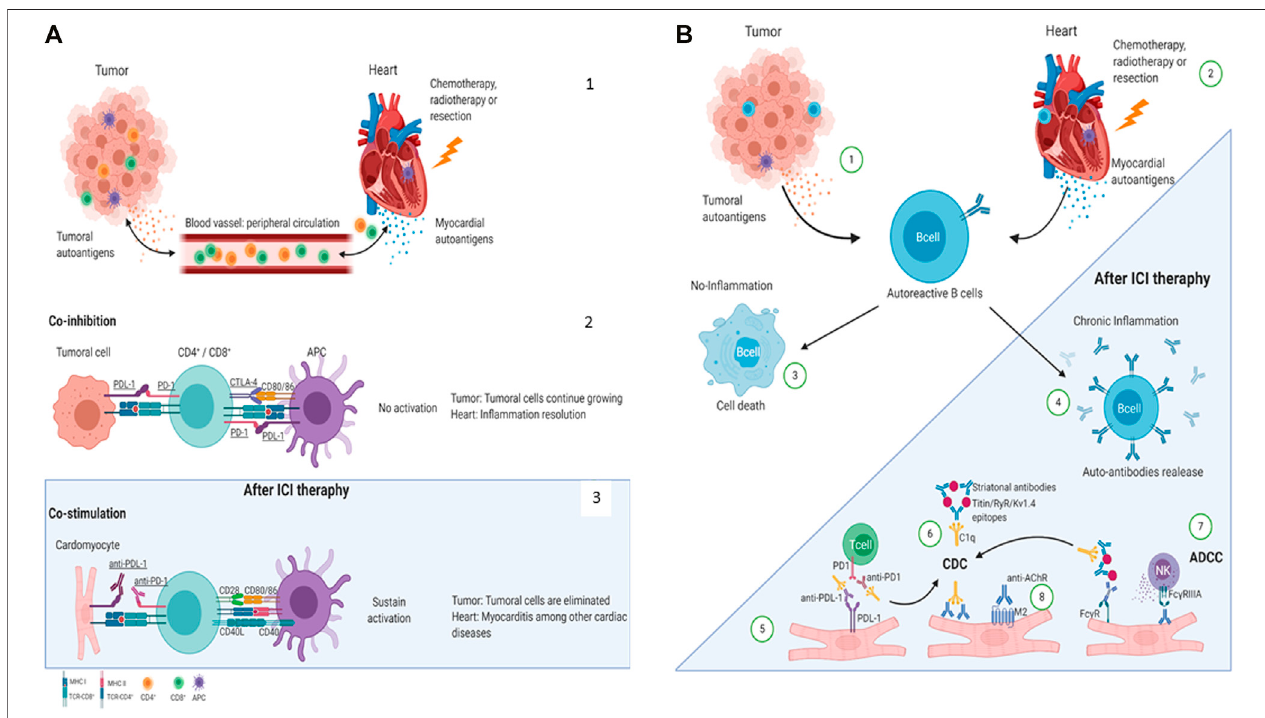
FIGURE 1 | Proposed mechanisms of ICI-related cardiac irAEs. (A) Cardiac antigens are released by injury or stress (Nirschl and Drake, 2013). T-cell inhibition by the co-inhibitory molecules CTLA-4, PD-1, PD-L1 (Drugs@FDA, 2021). ICIs block the co-inhibitory molecules on T-cell or APC and induce anti-tumor effects (Drugs@ FDA, 2021) or, in some cases, heart damage (Dyck and Mills, 2017). (B) Mechanisms of autoantibodies mediated cardiac irAEs after ICI therapies. Tumoral (Nirschl and Drake, 2013) and cardiac (Drugs@FDA, 2021) auto-antigens might be released by dying cells and damaged tissue in response to chemotherapy, radiotherapy, or resectionandberecognizedbyautoreactiveBcells.Bcellscannotbeactivatedintheabsenceofanin fl ammatorymilieuandbecomenon-viable.(DyckandMills,2017). However, ICI therapies promote a chronic proin fl ammatory milieu allowing autoreactive B-cell activation to produce autoantibodies (Vaddepally et al., 2020). The PD-L1 expression has been reported in cardiomyocytes in the heart; therefore, anti-PD-L1-mediated CDC or ADCC may be directed to the heart inducing cardiac irAEs (Khoja et al., 2017). Striational antibodies might form an immune complex and CDC (Picardo et al., 2019). Finally, autoantibodies can directly recognize their antigen on the cardiomyocyte ’ s surface, induce ADCC (Haanen and Robert, 2015), or promote an agonist/antagonist response (Rubio-Infante et al., 2021). AChR: acetylcholine receptor; ADCC: antibody-dependent cellular cytotoxicity; APC: antigen-presenting cell; C1q: complement component 1q; CD: Cluster of differentiationCD4+: T helper cell; CD8+: T cytotoxic cell; CDC: complement-dependent cytotoxicity; CTLA-4: cytotoxic T-lymphocyte-associated antigen 4; Fc γ R: Fc gamma receptors; Kv1.4: potassiumvoltage-gatedchannel; M2: muscarinicacetylcholinereceptor 2;PD-1:programmed death 1;PD-L1: programmed death-ligand1;RyR: ryanodine receptor. Created with